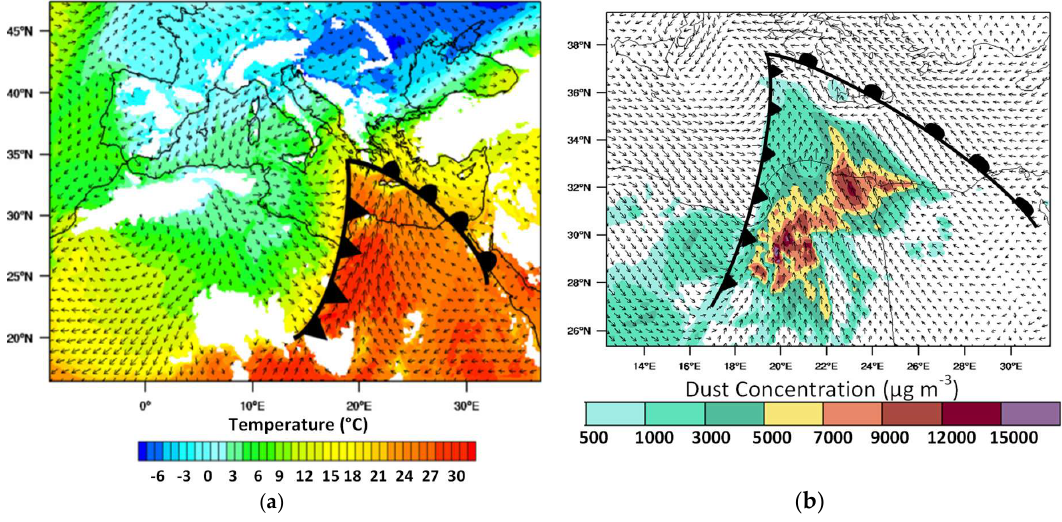
Figure 5. ( a ) Frontal activity, temperature (°C) and wind vectors at 925 hPa and ( b ) Near-surface dust concentration (μg m −3 ) and wind vectors at 10 m (zoom from the external 12 × 12 km domain), on 22 March 2018 0600 UTC.